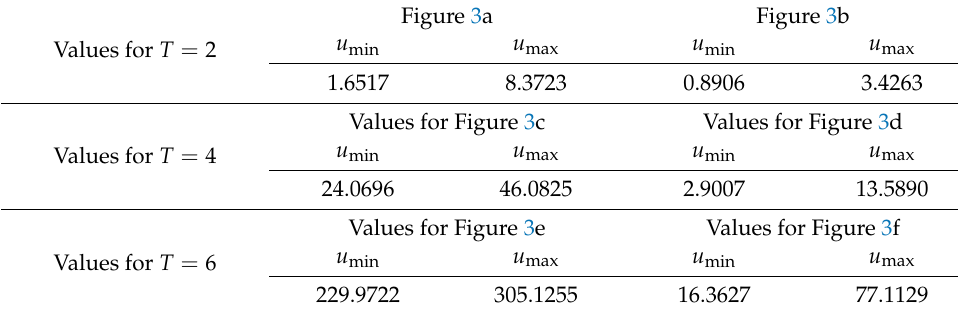
Table 2. Minimal and maximal values of the state u at T = 2,4,6 for Figure 3.